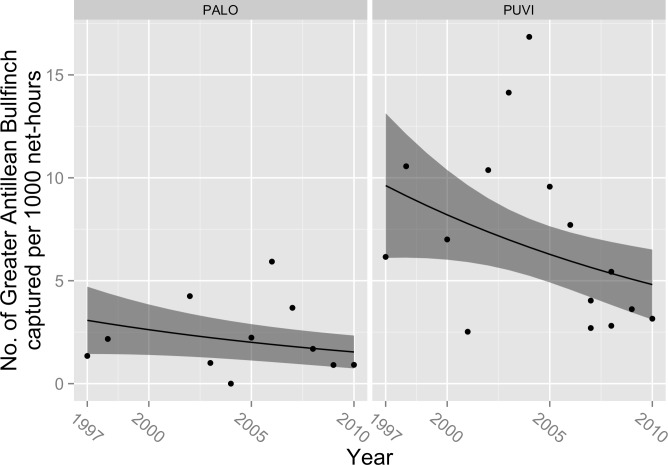
Trends in capture rate of Greater Antillean Bullfinch (Loxigilla violacea).Observed capture rate (dots) of Greater Antillean Bullfinch and changes in expected capture rate (solid line; shaded area = 95% confidence interval) per 1,000 net-hours at two sites (PALO, Palo de Agua; PUVI, Pueblo Viejo) in montane broadleaf forest of Sierra de Bahoruco, Dominican Republic.